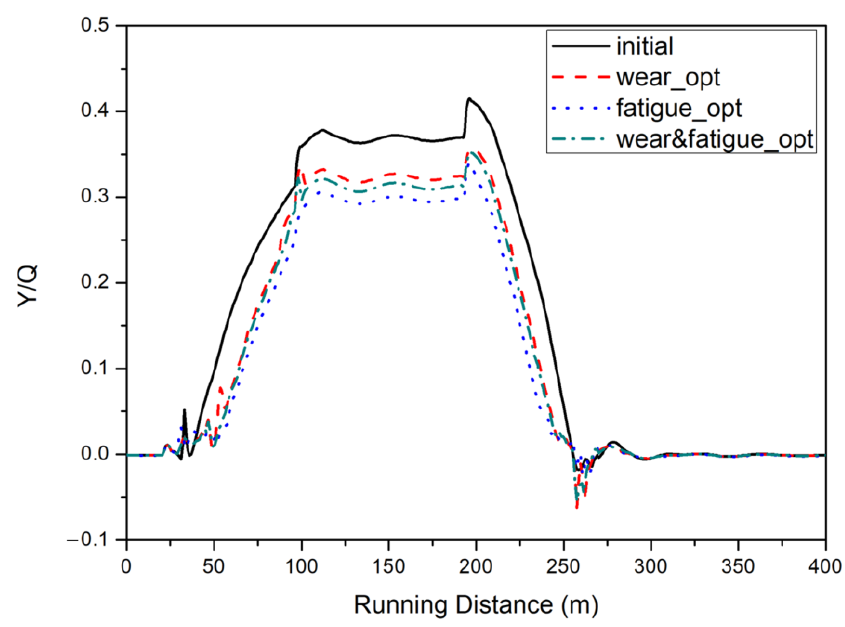
Figure 15. Derailment quotient of wheel.